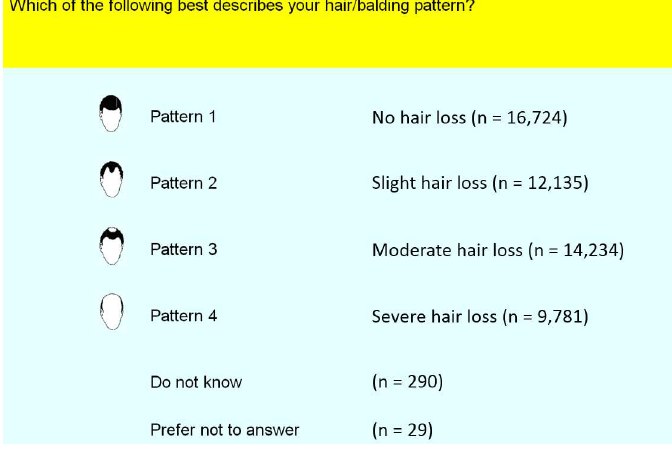
Fig 4. Screenshot of UK Biobank question 2395 on male pattern baldness, adapted with